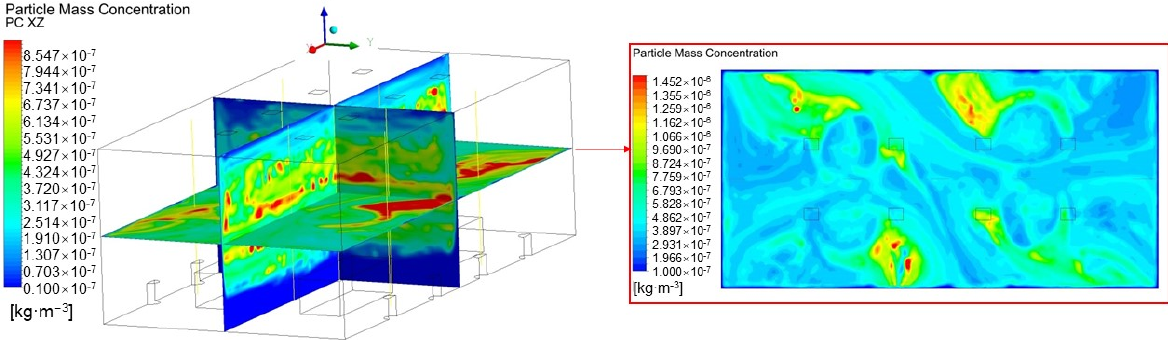
Figure 6. Particle concentration field in XZ plane at Y = 7.5 m, YZ plane at X = 15 m, and XY plane at Z = 5 m under ACR = 3.